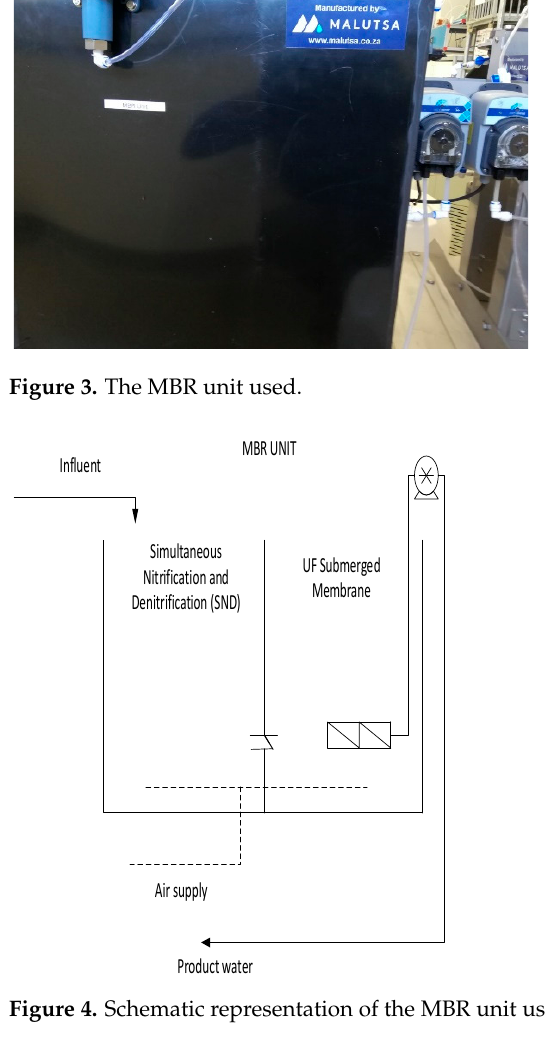
Figure 5. The MBR unit with a membrane compartment and an SNaD during inoculation. 2.10. Sample Collection and Analyses for the Lab-Scale Plant Throughout the study, a volume of either treated or untreated (to be fed to another unit) wastewater was analyzed for temperature, pH, COD, biological oxygen demand (BOD), electric conductivity, alkalinity (CaCO 3 ), fats, oil, and grease (FOG), total dissolved solids (TDS), total suspended solids (TSS), dissolved oxygen (DO), and volatile fatty acids (VFAs) [21,22]. 2.11. Analytical Methods for the Lab-Scale Plant Samples All samples were analyzed for characteristic parameters at the CoCT scientific ser- vices laboratory, according to the standardized American Public Health Association (APHA) methods [21]. 3. Results and Discussion 3.1. Pretreatment Stage Performance